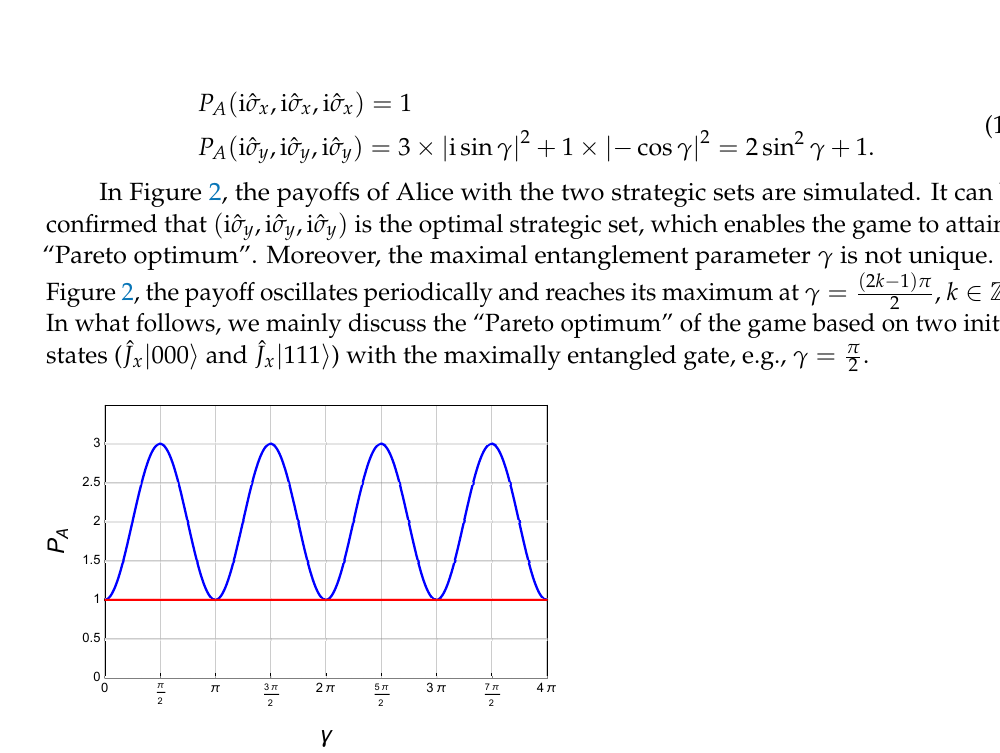
Figure 2. The red line denotes the payoff of Alice with the strategic set of ( iˆ σ x ,iˆ σ x ,iˆ σ x ) ; while the blue curve is that with the strategic set of ( iˆ σ y ,iˆ σ y ,iˆ σ y )